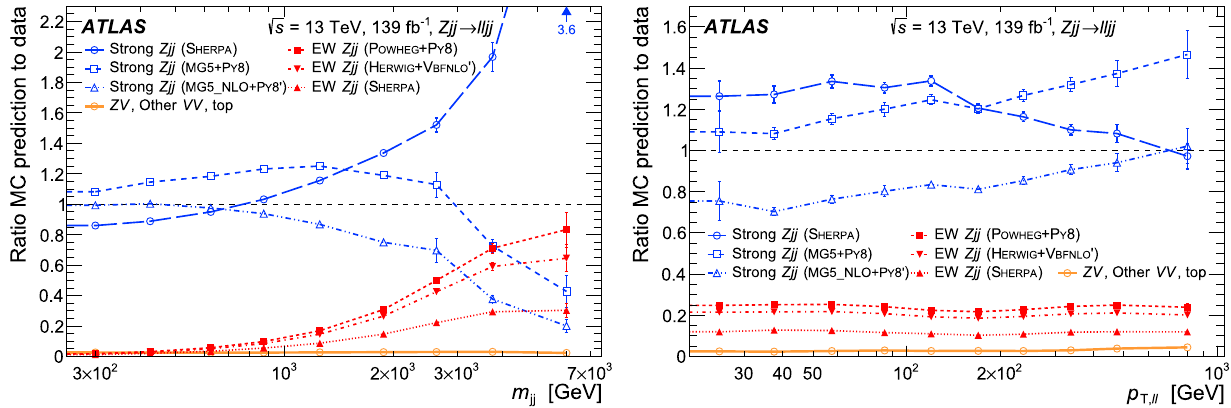
Fig. 3 Ratio of Monte Carlo prediction to data for different physics processes and generators for the m jj and p t ,(cid:3)(cid:3) distributions, following the event selection described in Sect. 4. The data contain all processes that pass the event selection and the ratio demonstrates the contribution to the observed event yield that is predicted by each MC generator. The m jj distribution extends down to 250GeV and hence includes a larger phase space than the p t ,(cid:3)(cid:3) distribution, which requires m jj > 1000GeV. Only statistical uncertainties are shown. The prediction labelled MG5_NLO+P y 8’ for the strong Zjj prediction is obtained by a particle-level reweighting of the strong Zjj simulation provided by MG5+P y 8. The EW Zjj prediction labelled Herwig 7+ Vbfnlo ’ is also obtained by a particle-level reweighting of the EW Zjj simulation provided by Powheg + Py